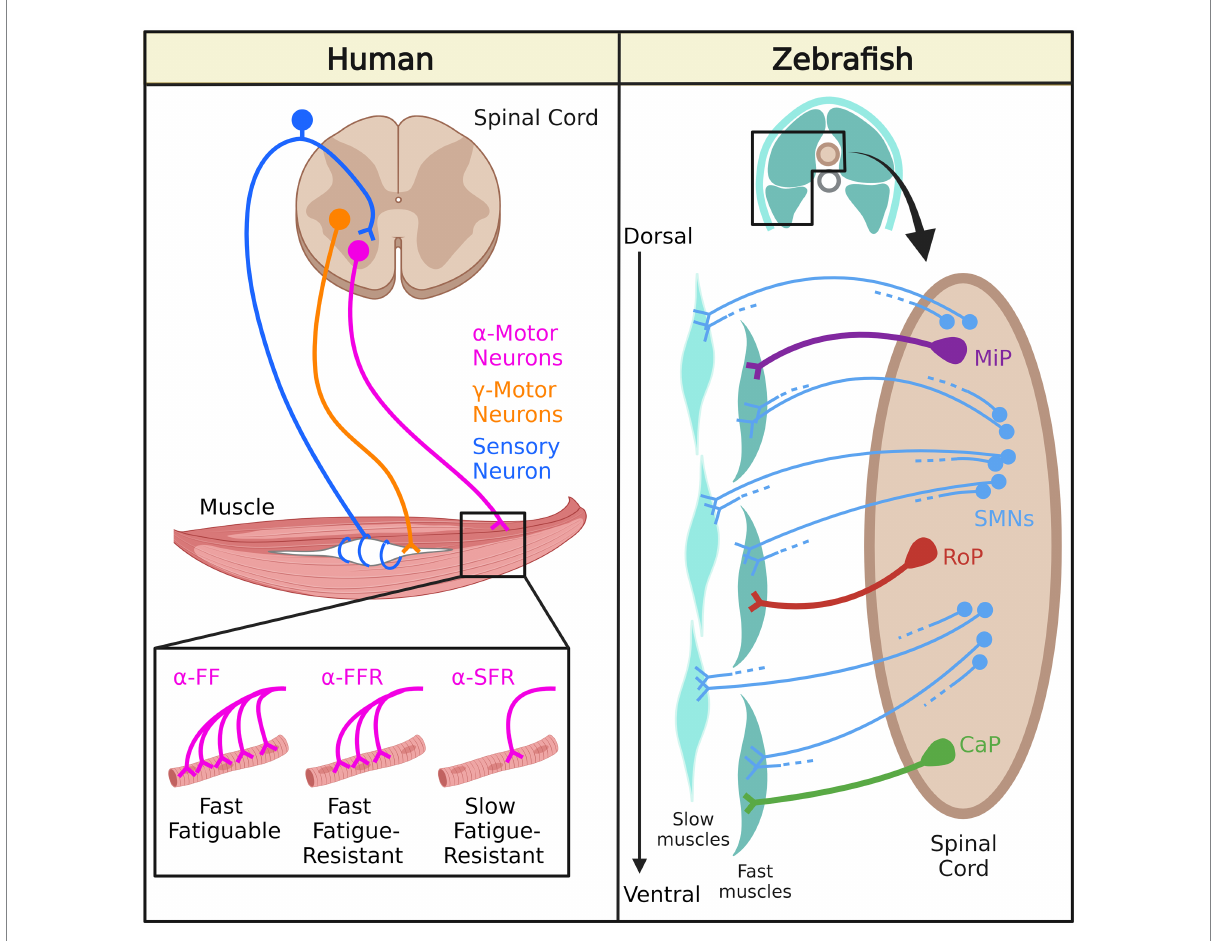
FIGURE 1 Neuromuscular system organization in human and zebrafish. In humans, γ -motor neurons innervate intrafusal muscle fibers while α -motor neurons innervate extrafusal muscle fibers: α -FF motor neurons densely innervate fast fatigable (FF) fibers, α -FFR motor neurons moderately innervate fast fatigue-resistant (FFR) fibers, and α -SFR motor neurons sparsely innervate slow fatigue-resistant (SFR) fibers. In zebrafish, secondary motor neurons (SMNs) innervate slow muscles and fast muscles. Middle primary motor neurons (MiP) innervate dorsal fast muscles, caudal primary motor neurons (CaP) innervate ventral fast muscles, and rostral primary motor (RoP) neurons innervate intermediate